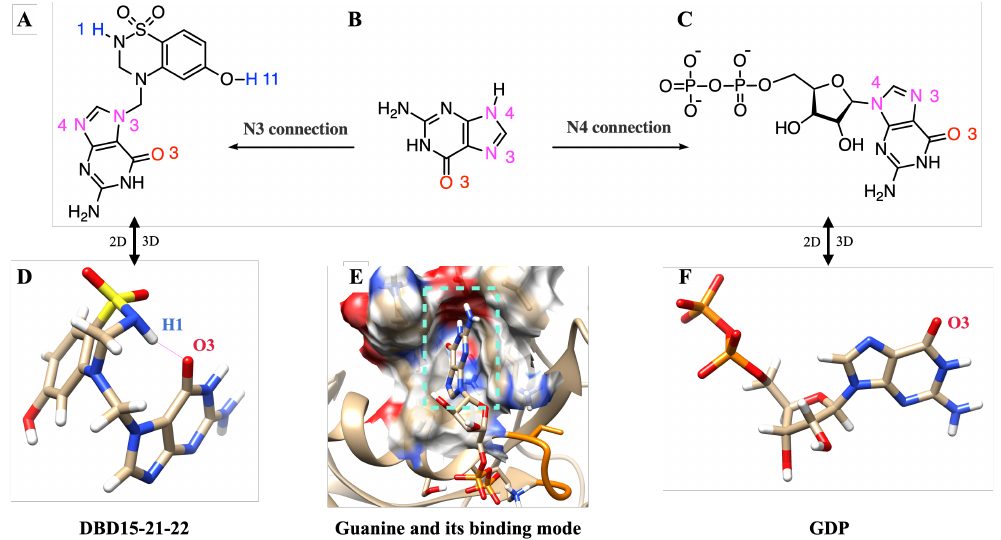
Figure 5. DBD15-21-22 cannot bind to the GDP/GTP binding pocket of KRAS-WT: ( A ) 2D structure of DBD15-21-22; ( B ) 2D structure of guanine; ( C ) 2D structure of GDP; ( D ) 3D structure of DBD15-21-22 in water; ( E ) GDP-binding model of KRAS-WT; ( F ) 3D structure of GDP in